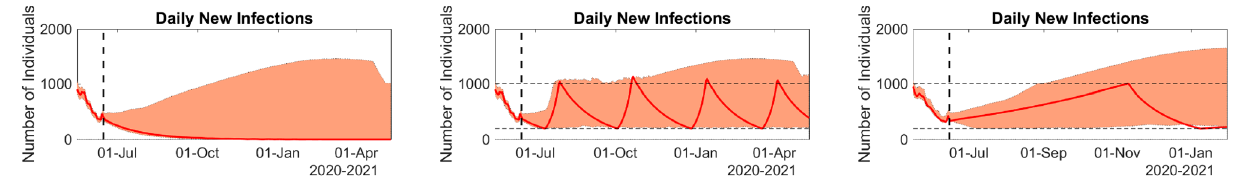
Figure 5. Model predictions of daily new infections for reopening scenarios. Left: containment measures are maintained during the whole period. Center: Reopening is allowed until the daily number of new infections reaches 1000 or if it is below 200 (horizontal dashed lines). Right: Reopening schools. The filled envelopes represent the 90% CIs. Figure generated with MATLAB R2019b